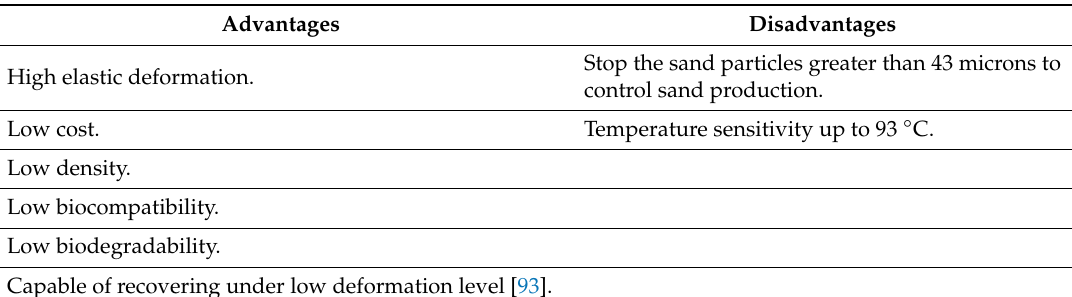
Table 14. Advantages and disadvantages of shape memory polymers methods.